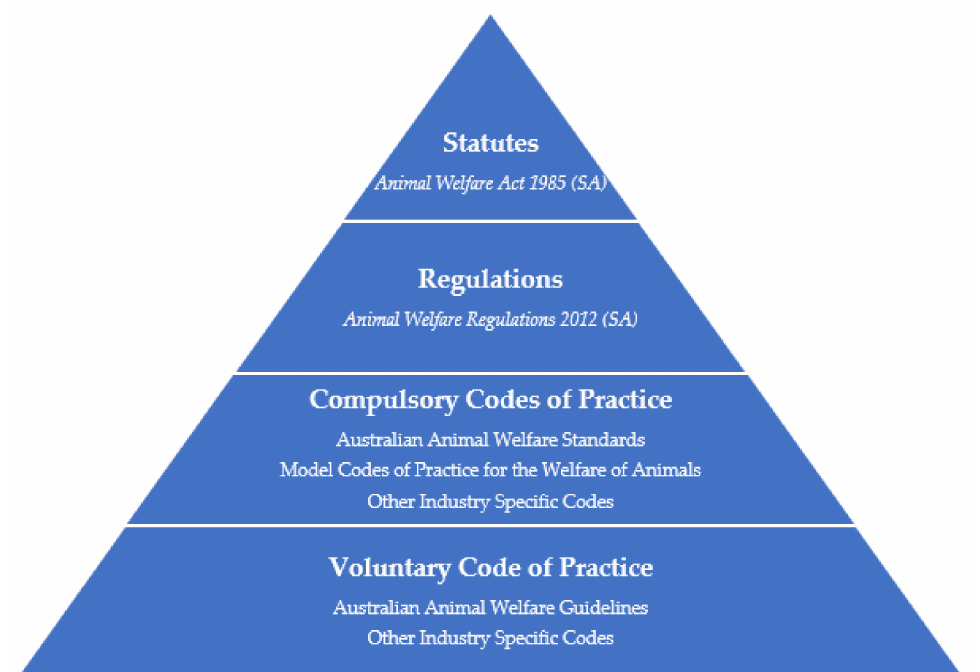
Figure 1. Hierarchy of state and territory legislation in relation to animal welfare protection. Note